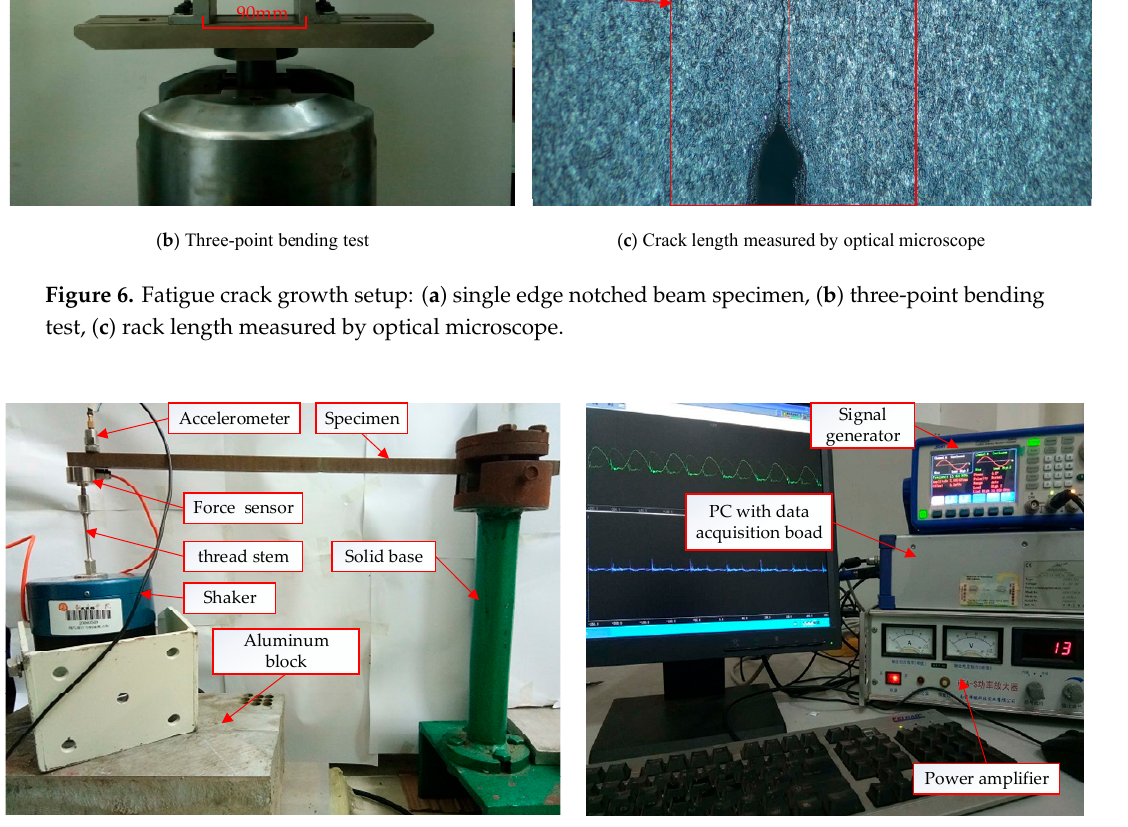
Figure 7. Vibration testing setup of the cantilever beam: ( a ) the structure of the vibrating system, ( b ) the system of the data acquisition.